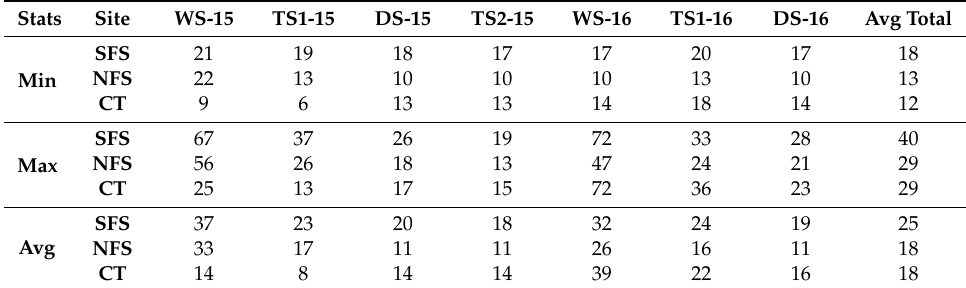
Table 3. Comparison of statistical values of SWS (in mm) of each site and hydrological season up to 0.4 m depth: Min (minimum), Max (maximum), Avg (average), and Avg total (total